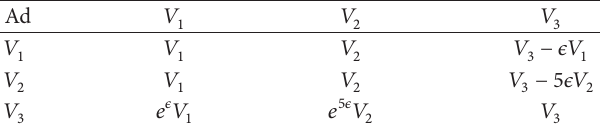
Table 2: Adjoint table of the Lie algebra of (1.2).